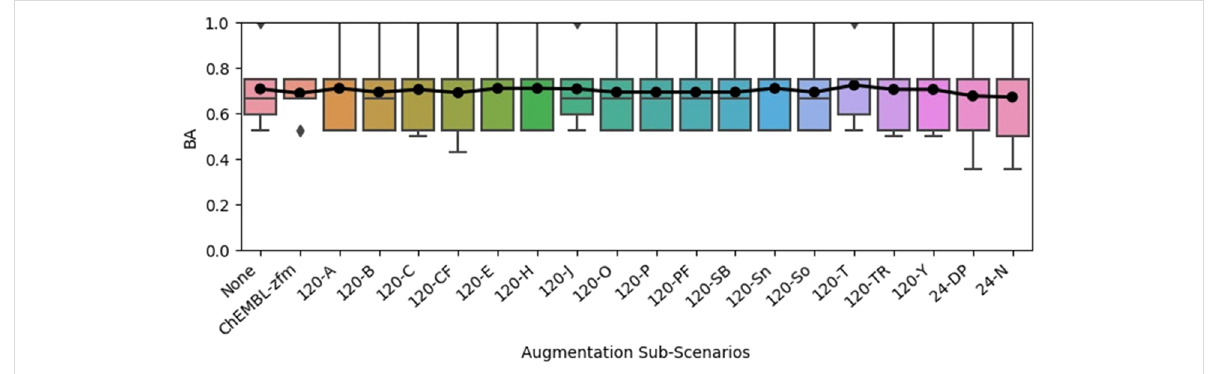
Figure 8: Nested cross-validated balanced accuracy (BA) obtained with multiple descriptor Random Forest models for the 120 hpf excess lethality endpoint when the cross-validation training sets were supplemented with weighted alternative samples, compared to the results obtained with no data augmentation (“None”). (The results with no data augmentation were reported in Table 1). Other than where molecular zebrafish lethality data from ChEMBL were treated as pseudo-coated ENM samples, all other alternative samples corresponded to the cross-validation training set with the modelled endpoint substituted with one of the sub-lethal endpoints. (See section “Endpoint abbreviations” under the Experimental section for an ex- planation of the 24 and 120 hpf sub-lethal endpoint abbreviations.) The results across all test folds are summarized in terms of a boxplot, with the arithmetic mean result superimposed. The whiskers extend to data points lying up to 1.5 times the interquartile range above and below the upper and lower quartiles, respectively. The triangles/diamonds represent outlier results, which are higher and lower than the upper and lower whiskers, respec- tively.